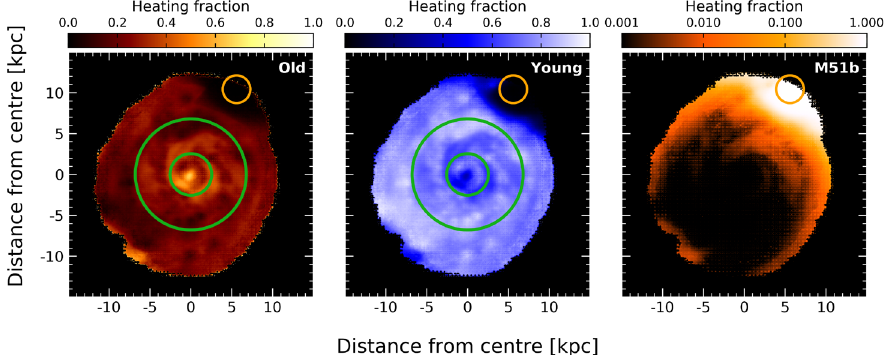
Figure 1. A schematic of the standard geometric model of spiral galaxies adopted in our studies. The model consists of an old stellar bulge and disk component, and two young stellar populations: a non-ionising (100 Myr), and an ionising (10 Myr). The dust distribution is assumed to have the same scale-height as the young non-ionising stars. Image Credit: [12]. Figure 2. Dust heating maps of a face-on view of M 51. Left panel: dust heating fraction by the old stellar population; middle panel: dust heating fraction by the young stellar populations; and right panel: dust heating fraction by M 51b. The gold circle indicates the extent of the dusty disk of M 51b. Image Credit: